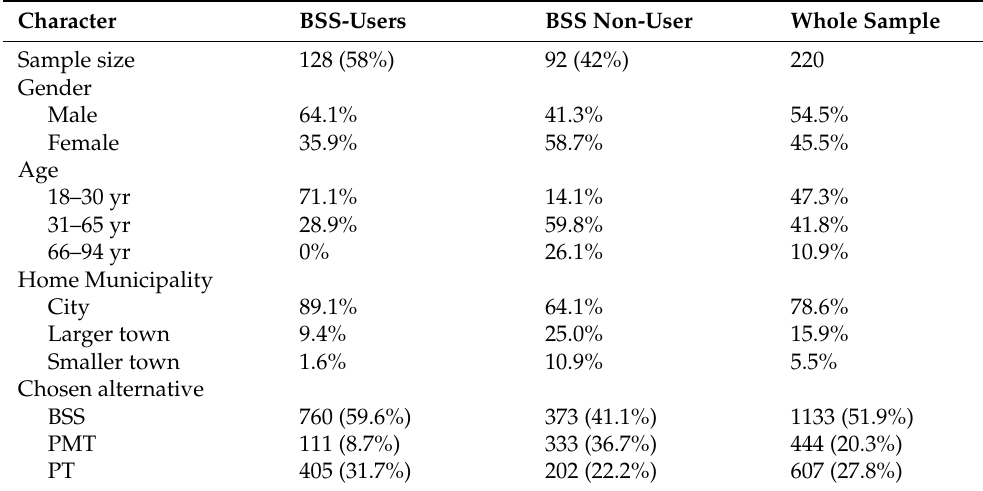
Table 3. Relative frequency distribution of selected sample characteristics.